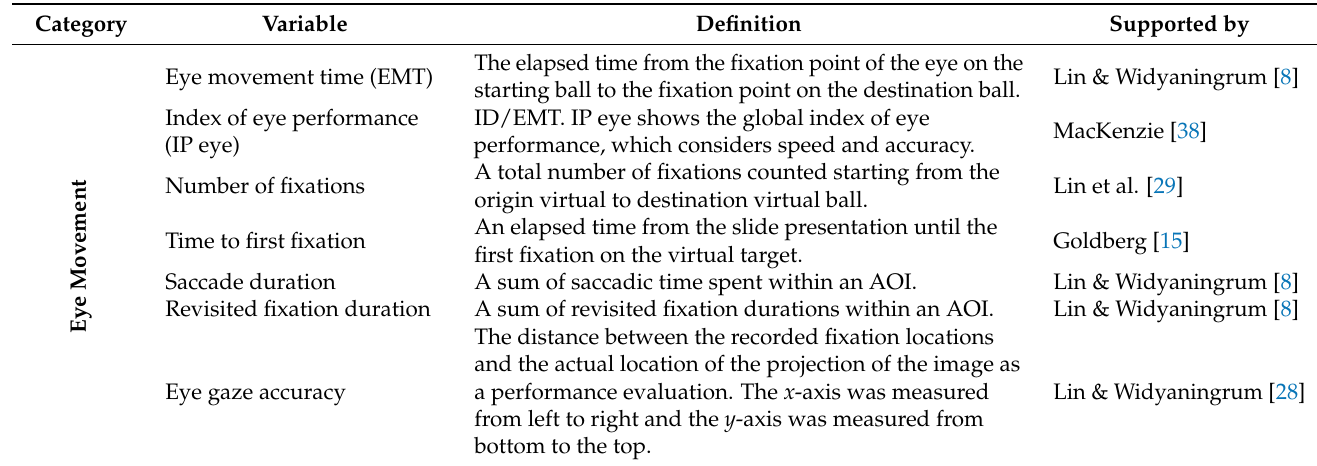
Table 2. Dependent variables and each